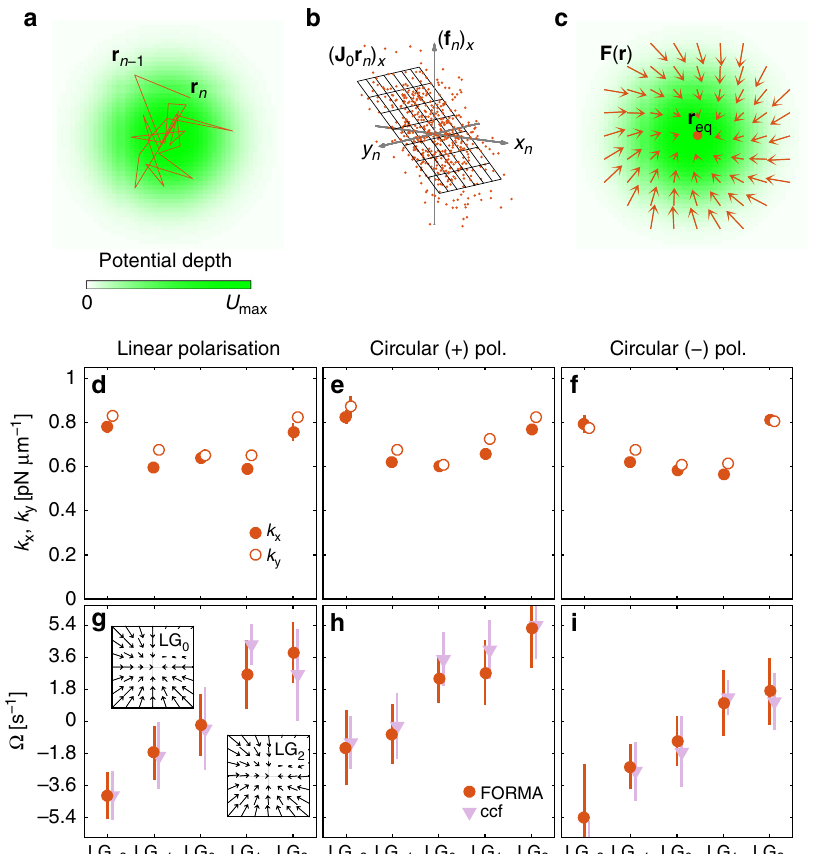
Fig. 3 Measurement of the non-conservative force- fi eld component. a – c Schematic of the 2D version of FORMA for a particle held in an optical tweezers: a Samples r n of a particle trajectory (solid orange line) held in an optical tweezers (the green background illustrates the depth of the potential) are acquired at times t n . b FORMA estimates the Jacobian J 0 of the force fi eld from the relation between r n and f n using a 2D MLE. In the schematic, we represent only the estimation of the fi rst row of J 0 , which is related to the x -component of f n ; the complete graph cannot be represented because it is 4D. c Using this information, FORMA reconstructs the force fi eld around the equilibrium point r eq (see also Supplementary Figure 3). d – f Stiffnesses k x and k y , and g – i angular frequency Ω of a Brownian particle optically trapped by d , g a linearly polarised, e , h circularly ( + ) polarised, and f , i circularly ( − ) polarised Laguerre- Gaussian (LG) beam with l = − 2, − 1, 0, 1,2. g – i The results of FORMA (orange circles) agree well with the results of the CCF analysis (pink triangles). The insets in g show the force fi elds for the case of a Gaussian beam (LG 0 ), which is purely conservative ( l = 0), and of a beam with a charge l = 2 of orbital angular moment (LG 2 ), which features a non-conservative component that only induces a mild bending of the arrows. In all cases, we have acquired trajectories of the motion of a spherical particle with radius R = 0.48 μ m in an aqueous medium of viscosity η = 0.0011 Pas − 1 at a sampling frequency f s = 4504.5s − 1 , and used 25 windows of 10 5 samples for the analysis; the error bars in d – i are the standard deviations over these 25